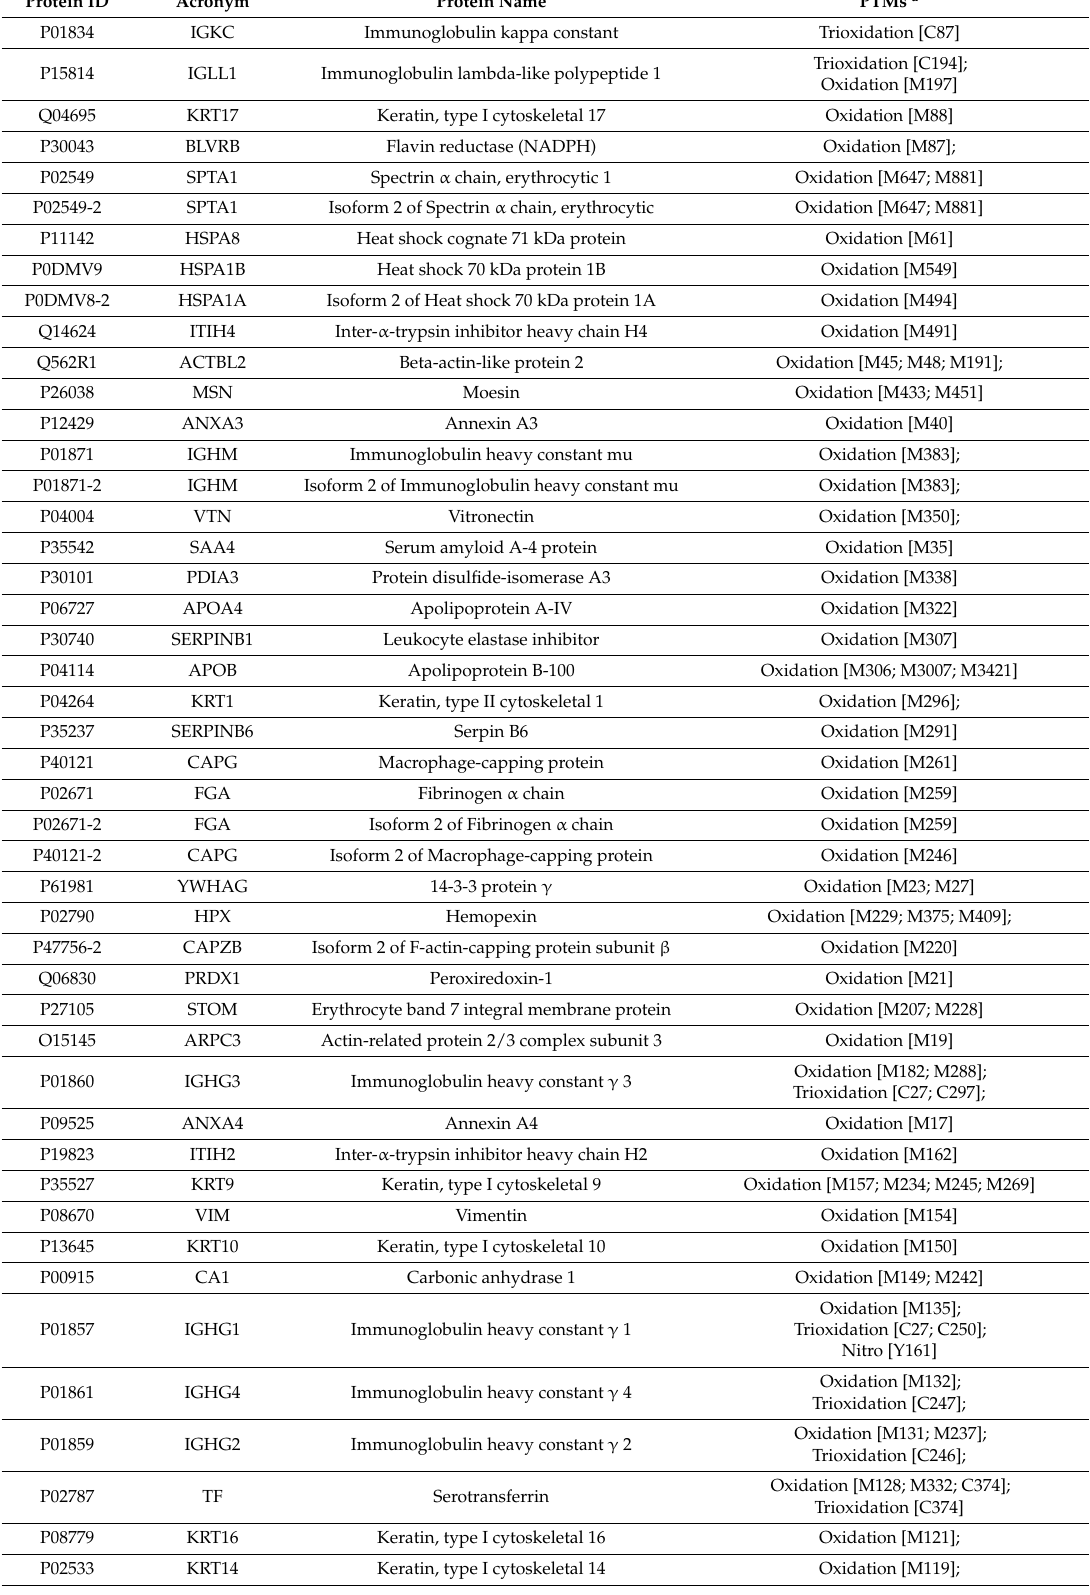
Table A3. PTMs found in wound fluids (high confidence hits